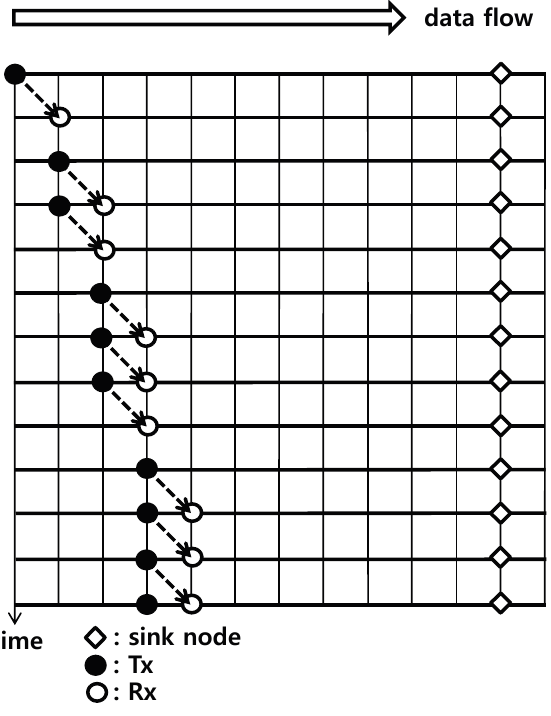
Figure 12. Transmission/reception timing of the packet train method.